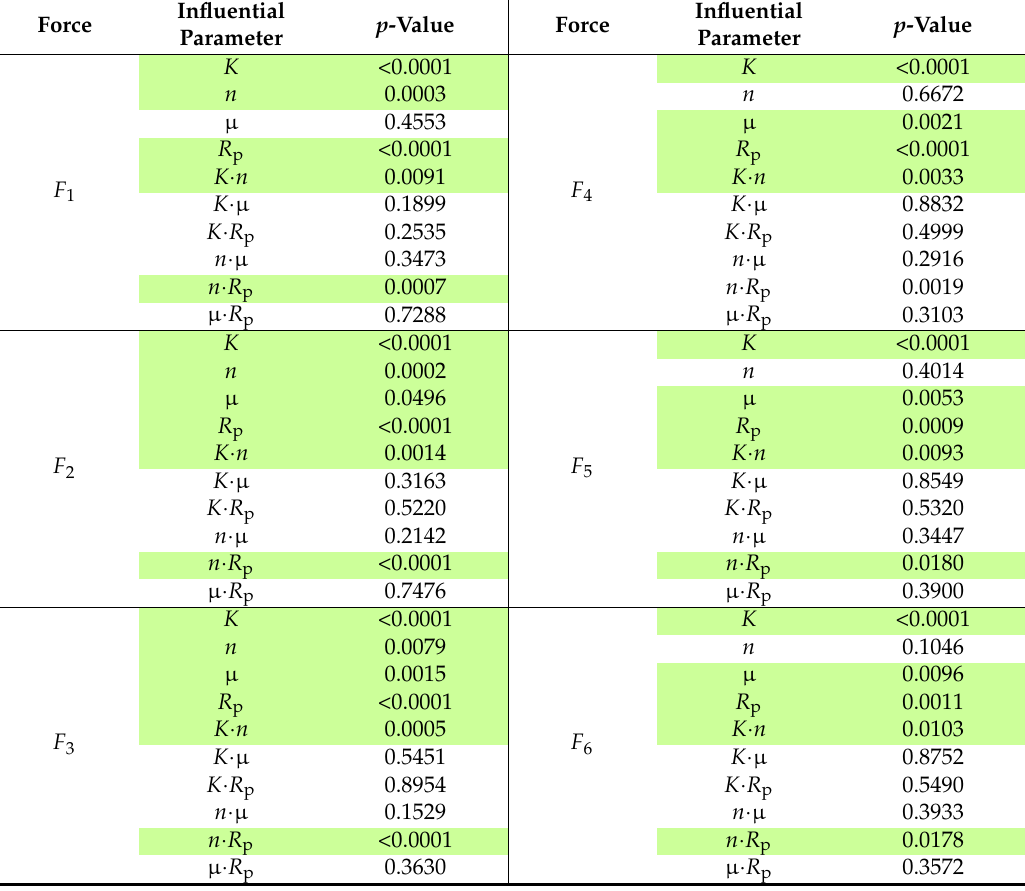
Table 5. The influence of the parameters K , n , R p , and µ , and their products on different levels of upsetting